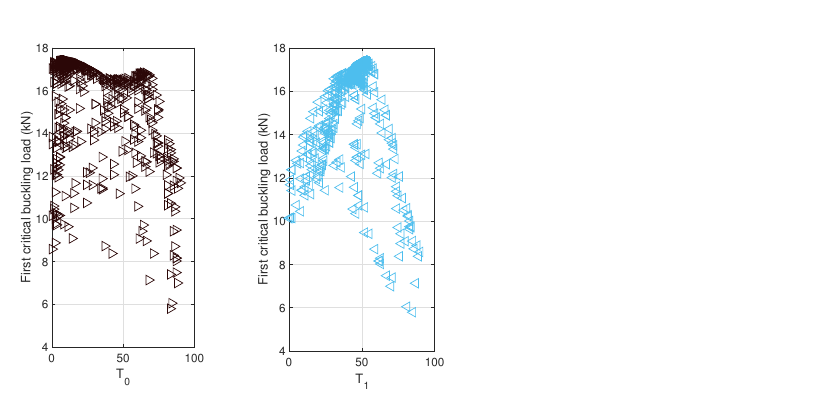
Figure 11. Distribution of variables and first critical buckling load, T 0 – T 1 ; first buckling load— T 0 , and first buckling load— T 1